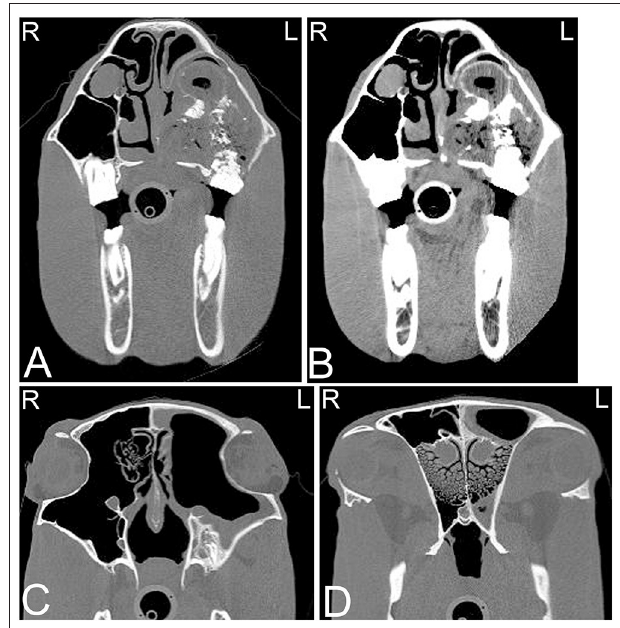
FIGURE 9 | Chronic lymphoplasmacytic sinusitis and right oronasal and oromaxillary sinus fistula. Transverse computed tomography images of the rostral (A,B) and caudal (C,D) aspect of the skull of a 20-year-old Paint horse with a large diastema between the right second and third maxillary molar teeth (Triadan 110 and 111), and a 2-year history of nasal discharge, which improved but not resolved with antibiotic treatment. In the rostral CT images in a bone (A) and soft tissue window (B) a heterogeneous soft-tissue attenuating mass with diffuse gas is noted surrounding the apices of Triadan 110 and 111 that is extending from the occlusal surface (white arrow) into the right maxillary sinus filling the entire rostral and part of the caudal right maxillary sinus. The roots of these two teeth are blunted and irregular, and the surrounded alveolar bone is disrupted. The right nasal passages are occluded by the mass. In the CT images of the caudal aspect of the skull displayed in a bone window (C,D) , a marked thickening of the mucosal lining of the left nasal cavity and left maxillary sinus is noted. Osteitis of the left maxillary bone with disruption and remodeling of the infraorbital canal is present. On histopathology a chronic lymphoplasmacytic sinusitis and rhinitis was noted. L, left; R,